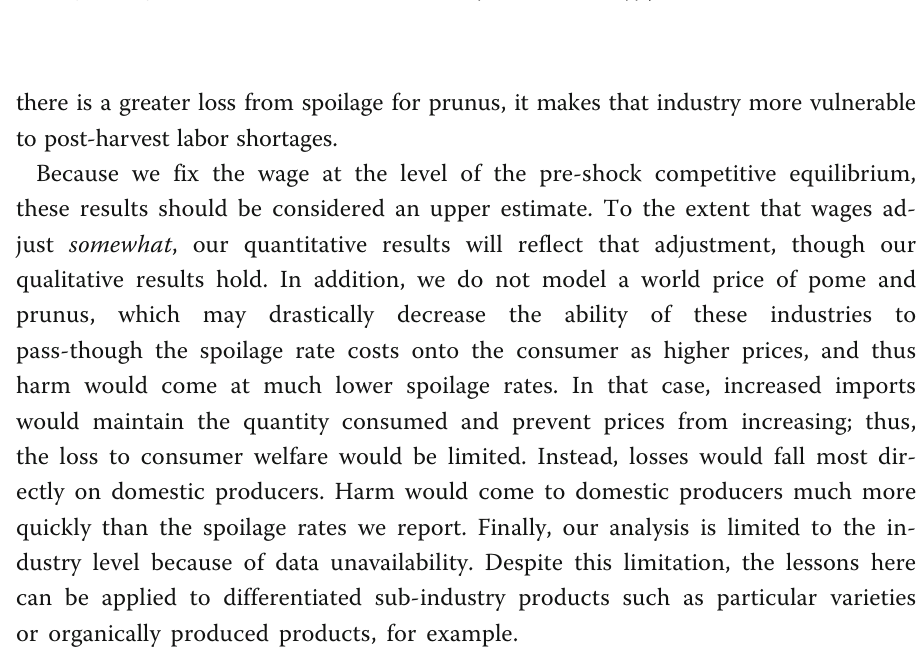
− 3703.18 0.19 − 6622.90 − 0.78 − 431.46 − 0.63